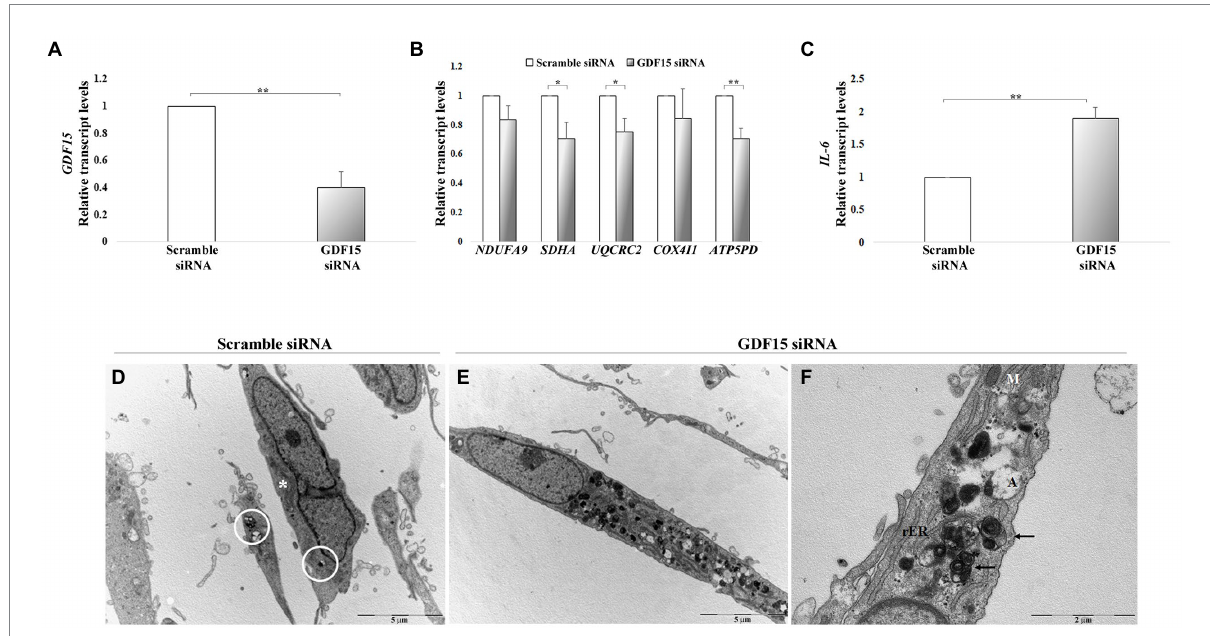
FIGURE 7 GDF15 knock-down (KD) in dermal fibroblasts (DFs). (A–C) Real-time RT-PCR analysis in DFs from fives non-demented old subjects in the age range 73–78 (ND) and 3 AD patients (AD) after GDF15 KD by small interfering RNA (siRNA) technique. Relative transcript levels of (A) GDF15 , (B) mitochondrial complex subunits ( NDUFA9 , SDHA , UQCRC2 , COX4I1 , ATP5PD ), and (C) IL-6 in scramble siRNA and GDF15 siRNA DFs. The bars represent mean ± SE. Student’s t and one-way ANOVA tests with Bonferroni correction were applied for transcript-level analyses. * p <